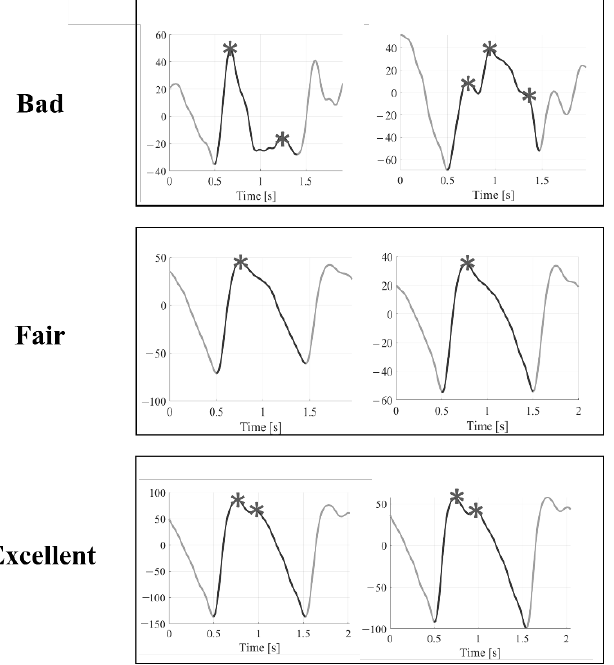
Figure 2. Examples of Bad, Fair, and Excellent quality pulses. Asterisks represent the local maxima for each pulse found by the Matlab findpeaks function.